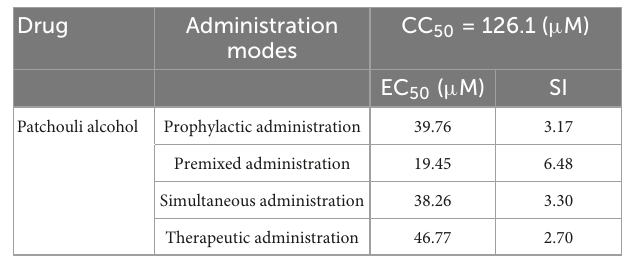
TABLE 1 Antiviral activity of Patchouli alcohol in MDCK cells.